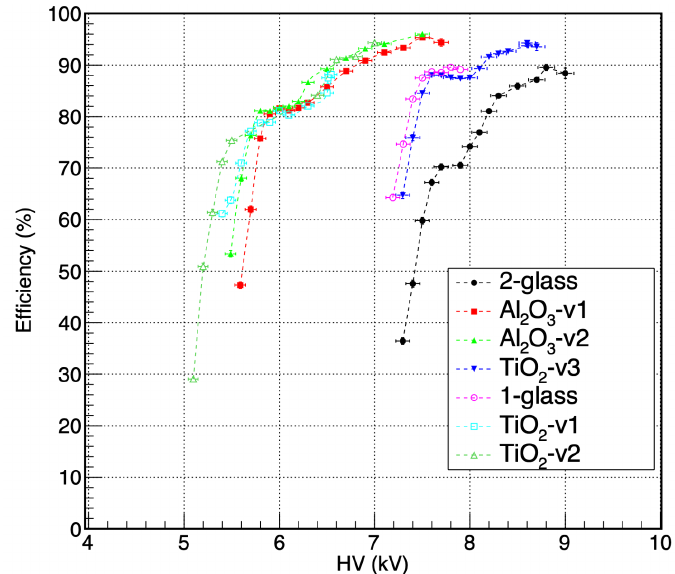
Figure 4. The efficiency as a function of applied high voltage for seven RPCs, including the five hybrid